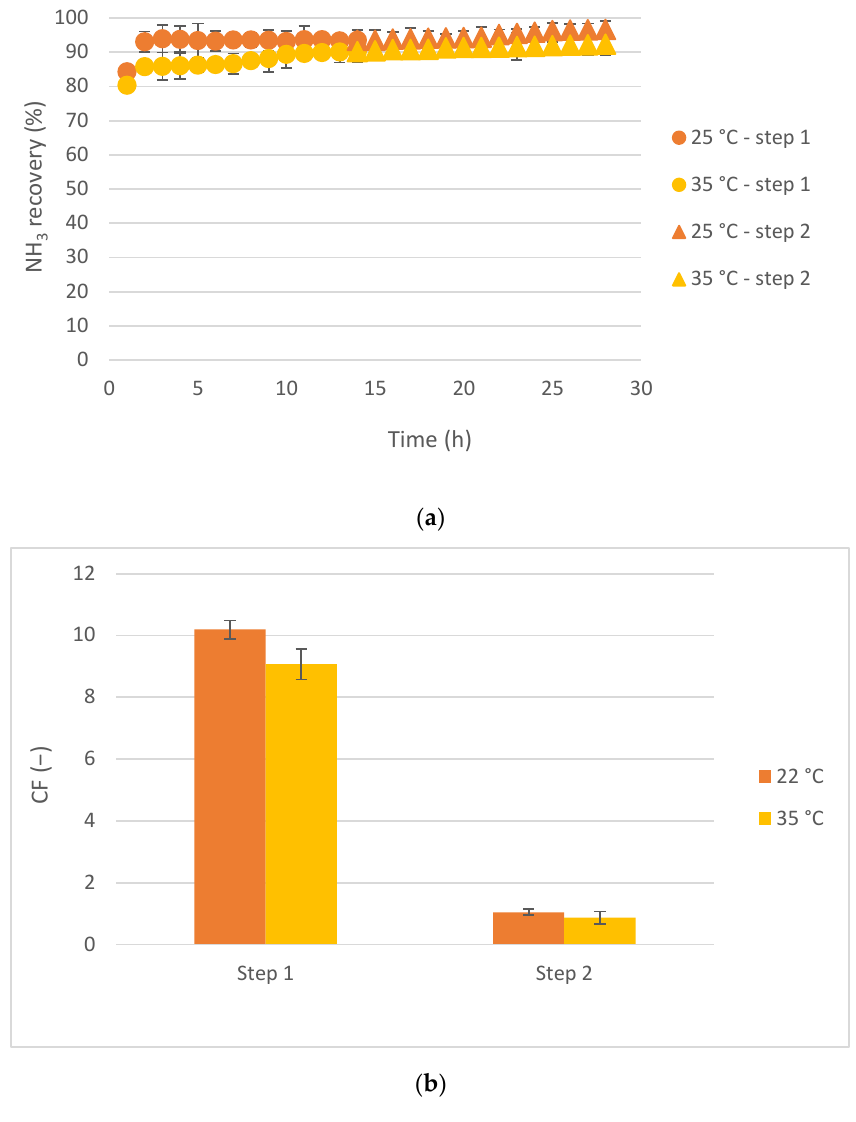
Figure 4. Temperature results comparison: ( a ) ammonia recovery and ( b ) concentration factor.